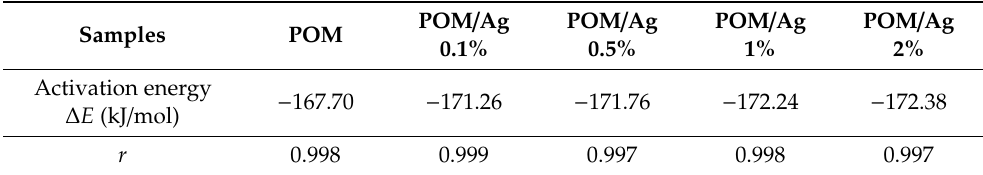
Φ / T 2 ) versus 1 / T P for the POM / Ag nanocomposites. Figure 12. Plots of ln( Φ / T 2 ) versus 1/ T P for the POM/Ag nanocomposites. Figure 12. Plots of ln( P P Table 6. Non-isothermal crystallization activation energy for the POM / Ag nanocomposites calculated using the Kissinger